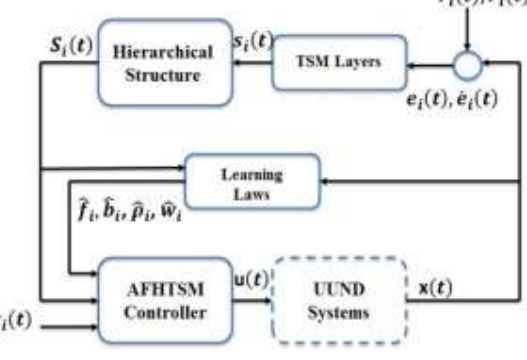
Figure 1. The schematic overall control